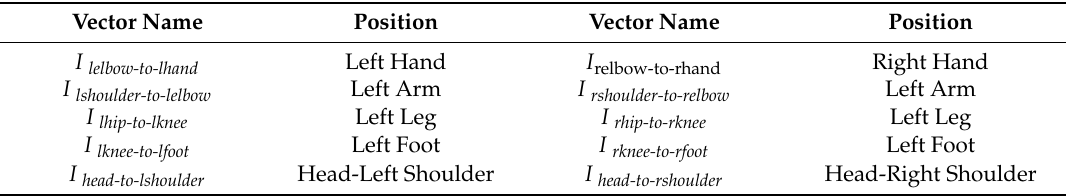
Table 2. Structure vectors of human body.